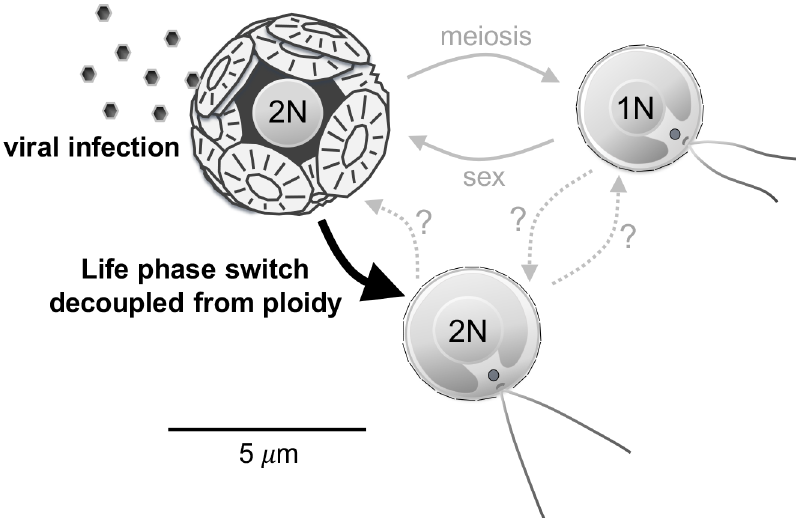
Fig 5. Schematic representation of the ‘Cheshire Cat’ mechanism in E . huxleyi in response to viral infection. As currently described, the haplodiplontic life cycle of E . huxleyi comprises a calcifieddiploidand noncalcified scale-bearing biflagellatehaploidstage that is resistant to specific viruses (EhV). Both diploidand haploidcells likely interconnect through meiosis and syngamy. Here, however,we show that in responseto infectionby EhV, E . huxleyi can producediploidbiflagellateand scale-bearing cells that are resistant to infectionas indicatedby the black arrow. This mechanismseems to be decoupled from the regular sexual cycle and to enable E . huxleyi cells to rapidly respondto and escape EhV infection. The fate of the diploid biflagellates is unknown,but they may revert back to the calcifiedstate or undergomeiosis to produceregular